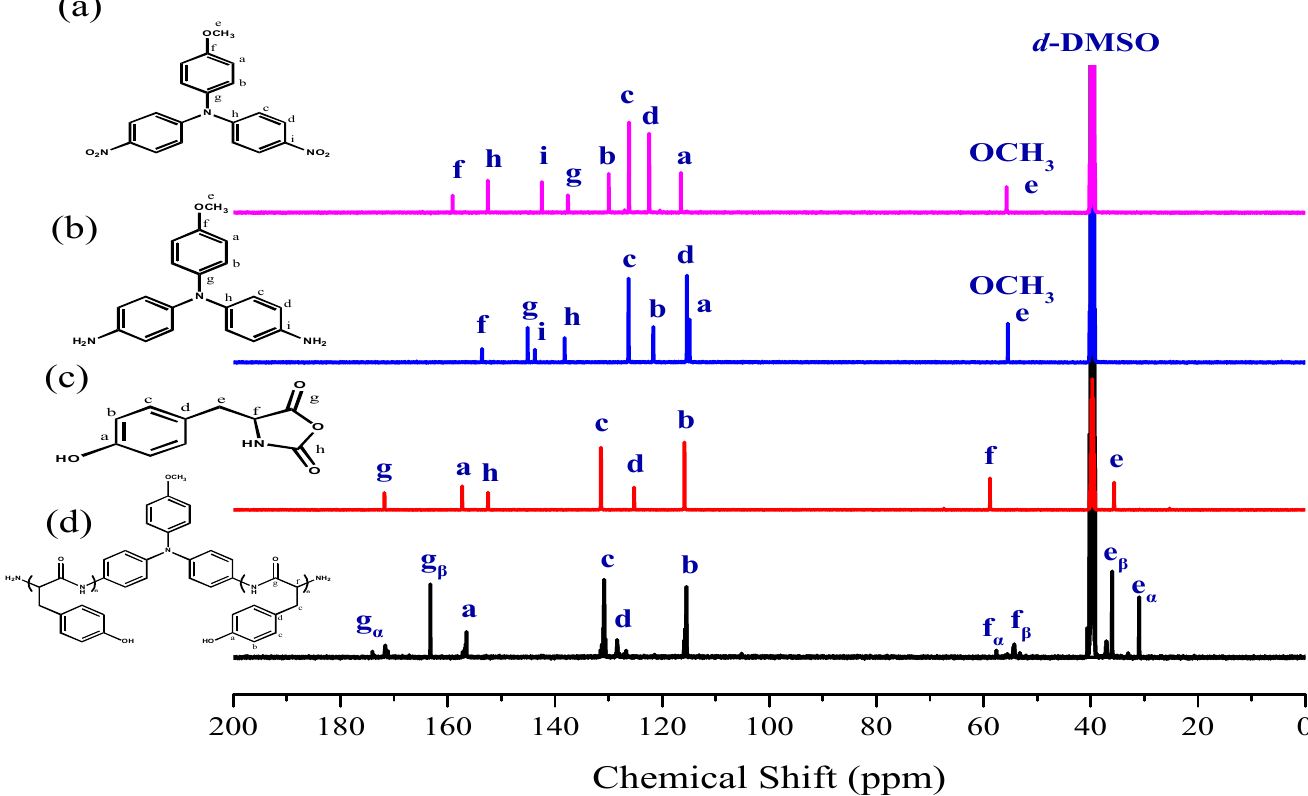
Figure 3. 13 C NMR spectra of: ( a ) TPA-NO 2 ; ( b ) TPA-NH 2 ; ( c ) Tyr-NCA monomer; and ( d ) PTyr*TPA.